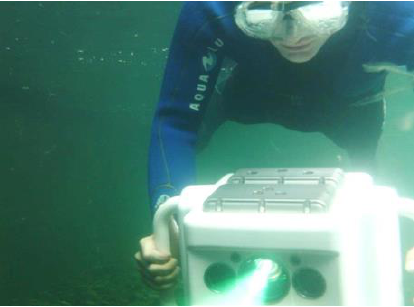
Figure 11. Underwater use of the scanner